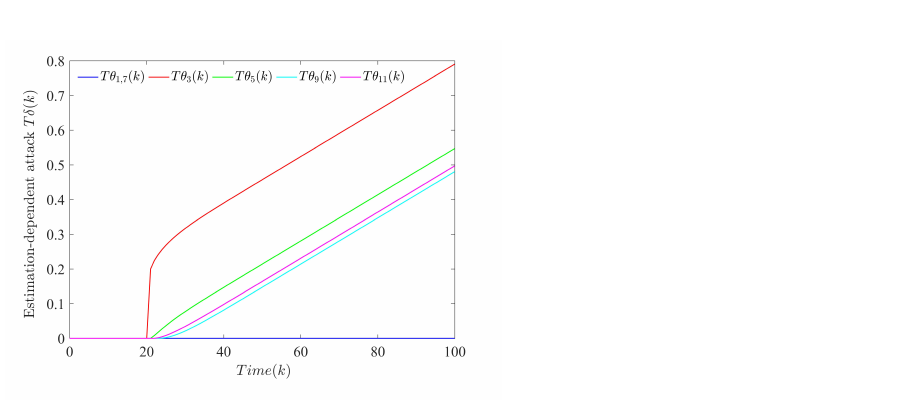
Figure 6. Dynamic generation process of the estimation-dependent attack given by Algorithm 1.